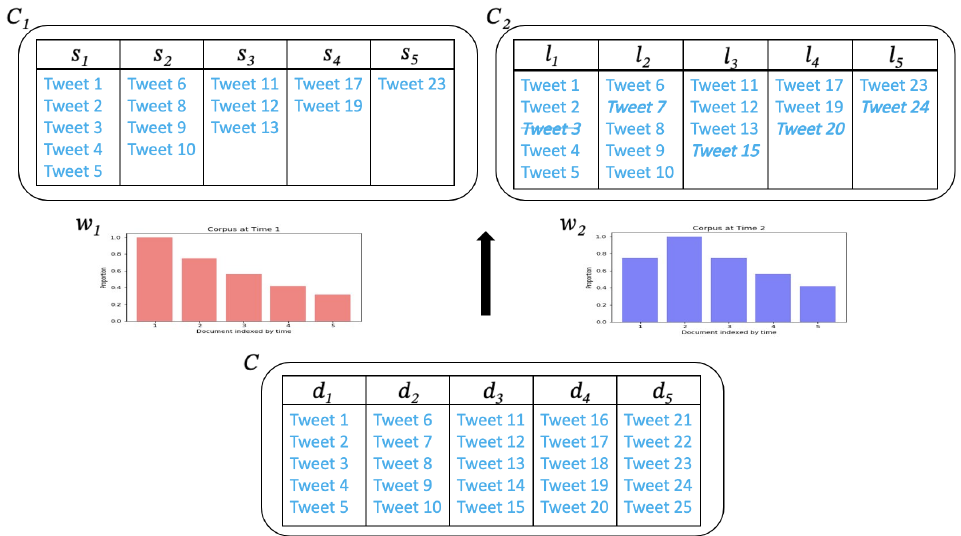
Figure 1. Conditional subsampling procedure using a hypothetical corpus com- posed of five documents each containing five tweets . For example, C = { d 1 , . . . , d 5 } , d 1 aggregates tweets from day 1 , d 2 aggregates tweets from day 2 , and so on. The subsampling weights for each document are shown in the bar plots and are exponentially decaying with a factor of 0 . 75 , centered at day 1 (left, w 1 ) and day 2 (right, w 2 ), respectively. Each newly generated corpus is a proportionally weighted random sample and a realization of these samples are shown in the tables ( C 1 and C 2 ). Note that the two corpora differ only by those highlighted and italicized